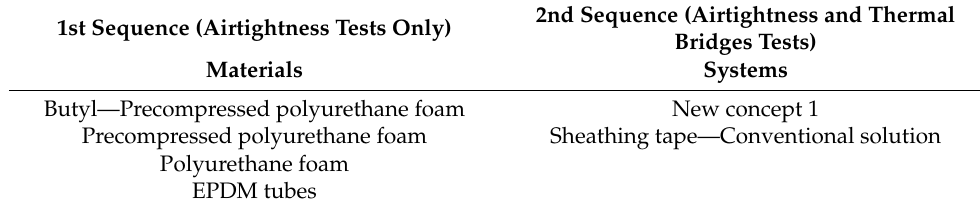
Table 1. Performed test sequences in the laboratory.